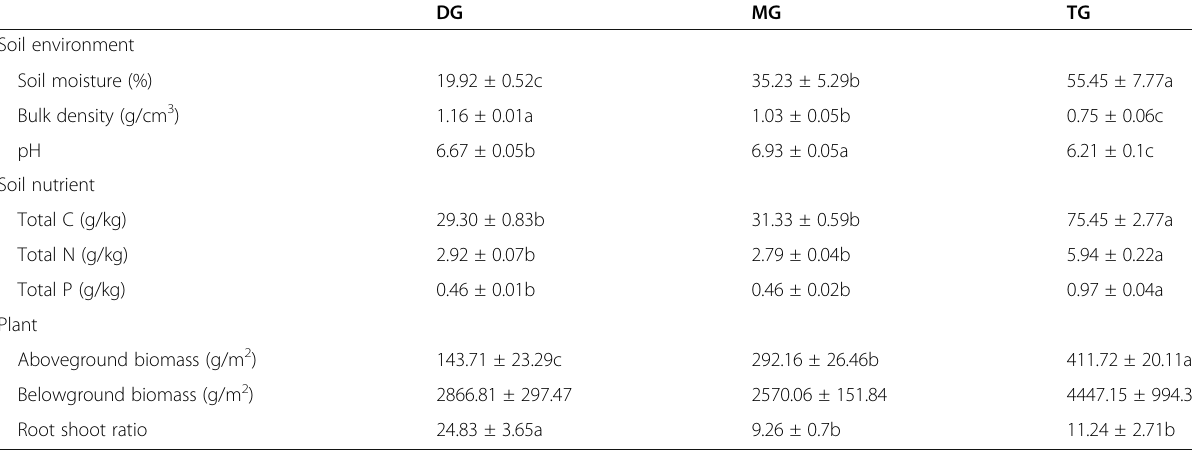
Table 1 Basic soil and plant characteristics along the grassland degradation